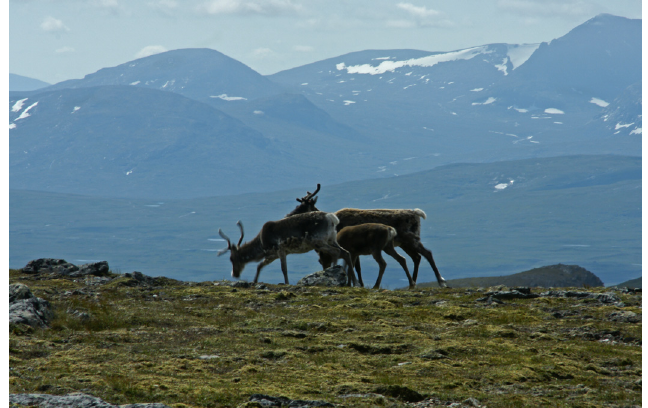
Figure 12: Despite heavy reindeer grazing, young saplings of birch and pine have become established on this alpine peak, 300 m above the treeline. Moreover the plant species rich- ness has increased by 156% since the mid-1990s (Kullman 2007a). Mt. Norder Tväråklumpen, 1250 m a.s.l. 9 August